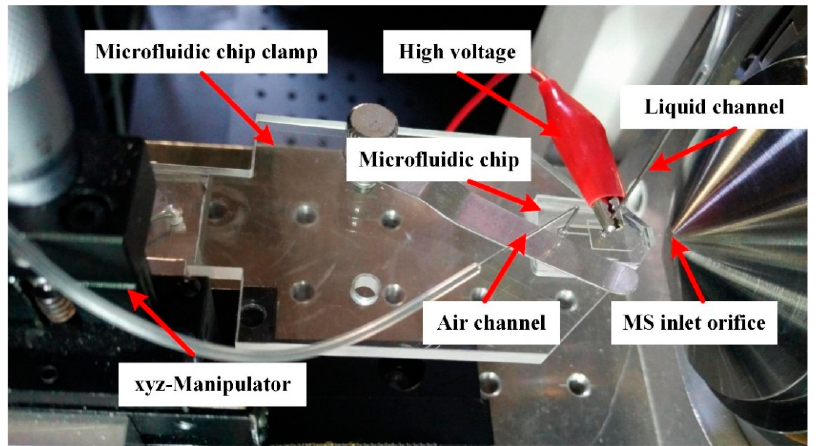
Figure 6. The configuration of the xyz-manipulator microfluidic chip with the mass spectrometer.